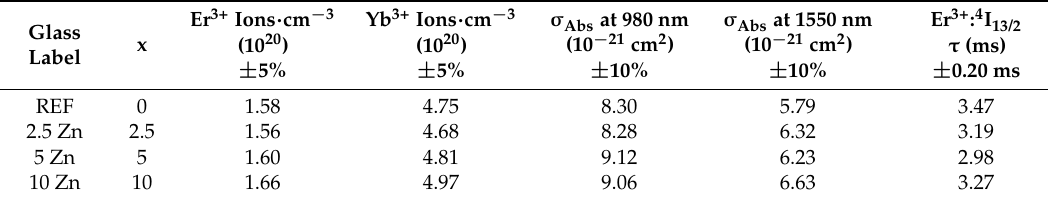
Figure 2. UV-Vis-NIR absorption ( a ) and normalized emission ( b ) spectra of the investigated glasses. The emission spectra were obtained using a 976 nm excitation. Table 2. Optical and luminescence properties of the